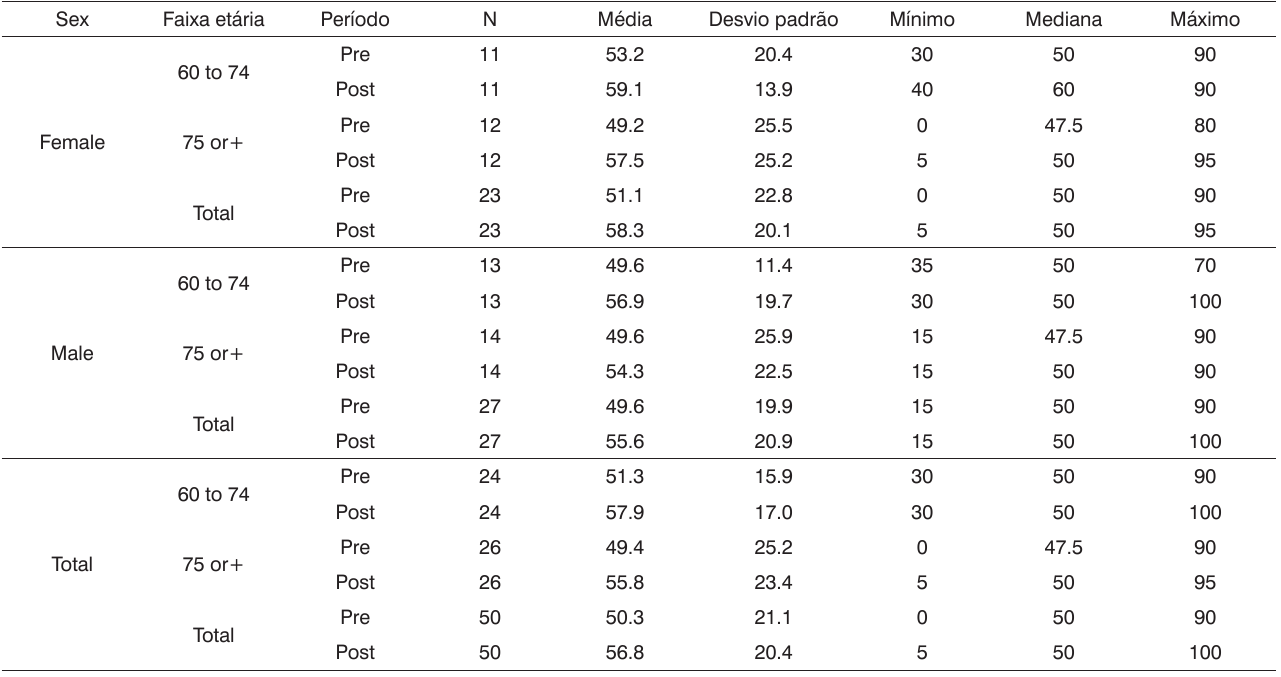
Table 4. Analysis of variance and descriptive statistics for the functional ability aspect according to sex and age group. Sex